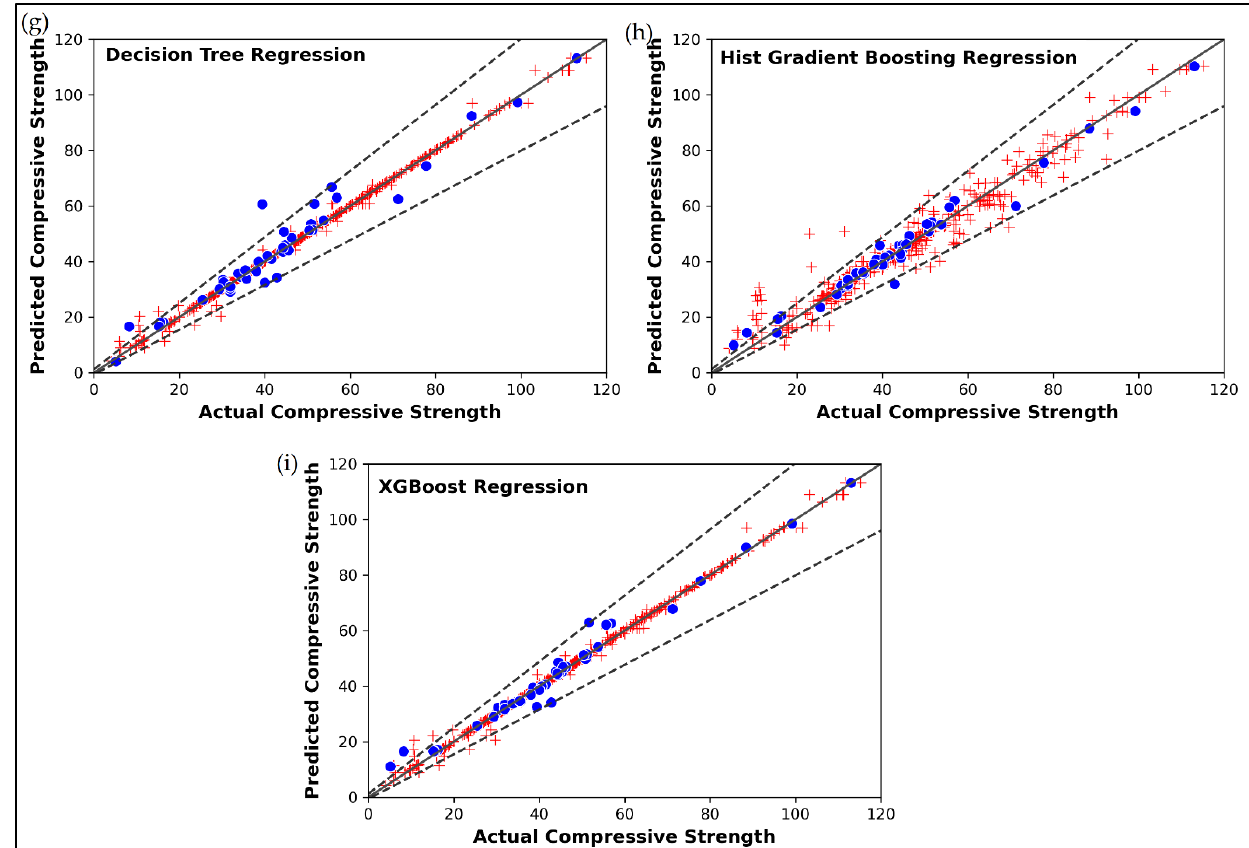
Figure 7. Actual versus predicted compressive strength of cement-based mortars using ( a ) linear regression, ( b ) random forest regression, ( c ) support vector regression, ( d ) AdaBoost regression, ( e ) multi-layer perceptron and ( f ) gradient boosting regression. Actual versus predicted compressive strength of cement-based mortars using ( g ) decision tree regression, ( h ) hist gradient boosting regression and ( i ) XGBoost regression. Table 2. Performance of the ML metamodels on training data.